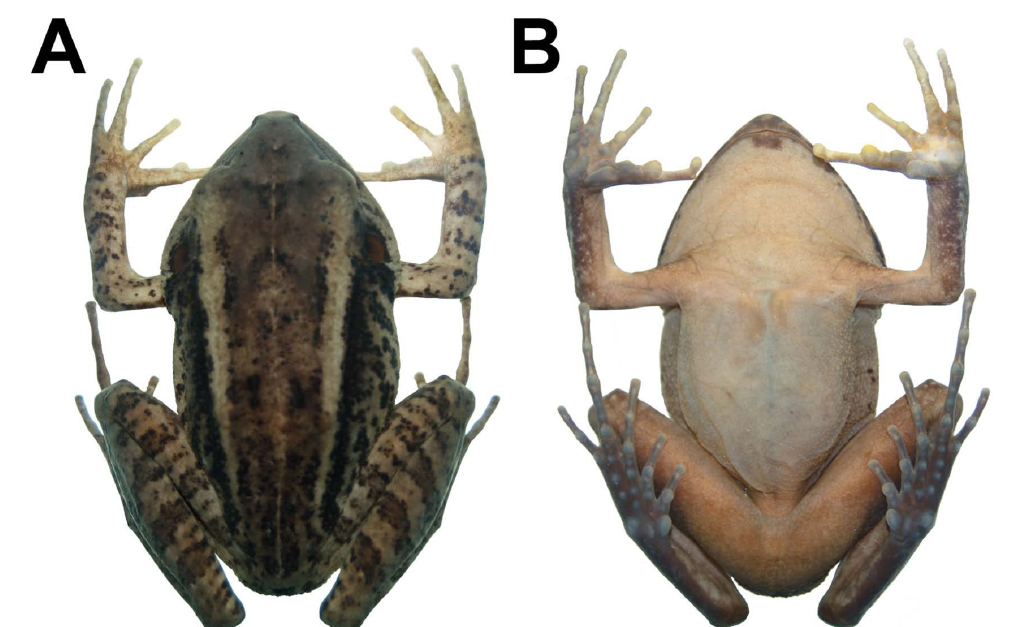
Figure 5. Strabomantis